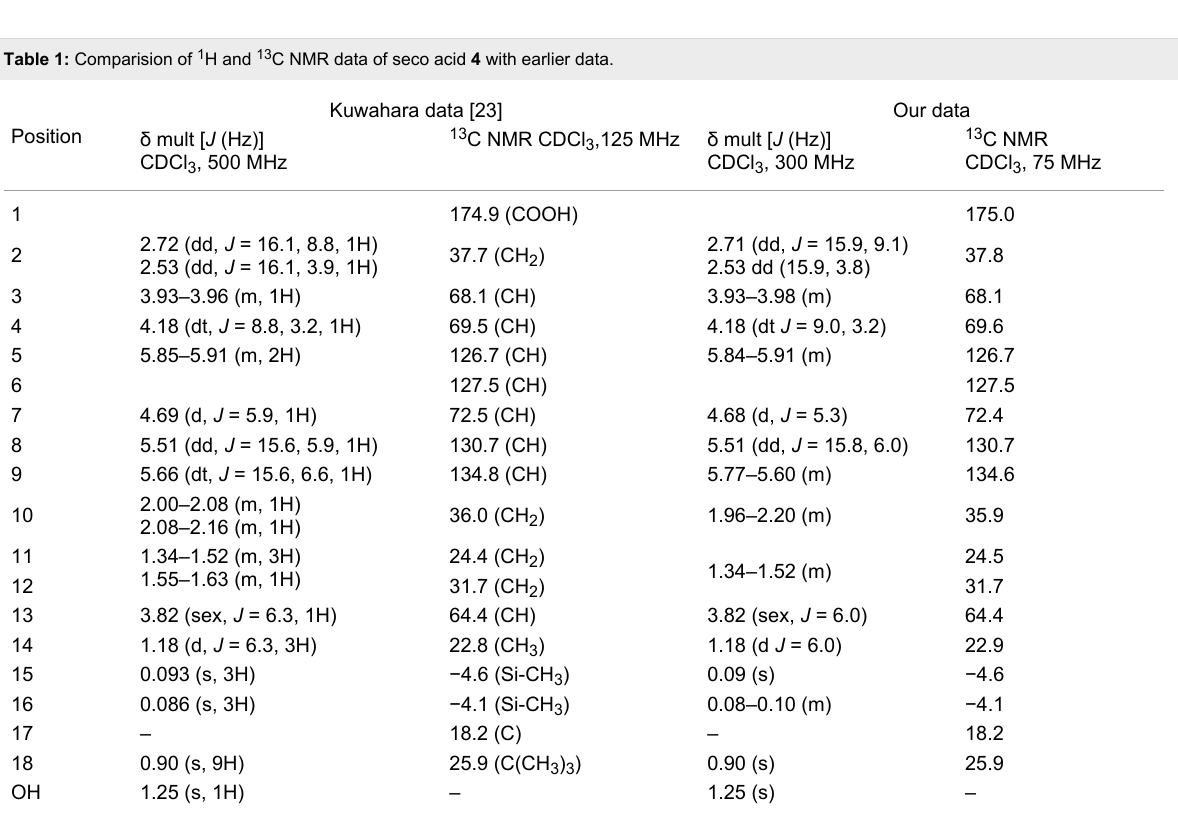
Kuwahara data [23]